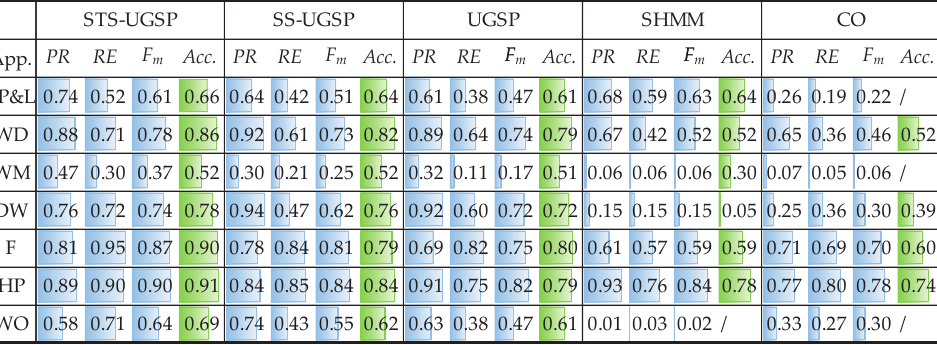
Figure 3. NILM Performance comparison on AMPds